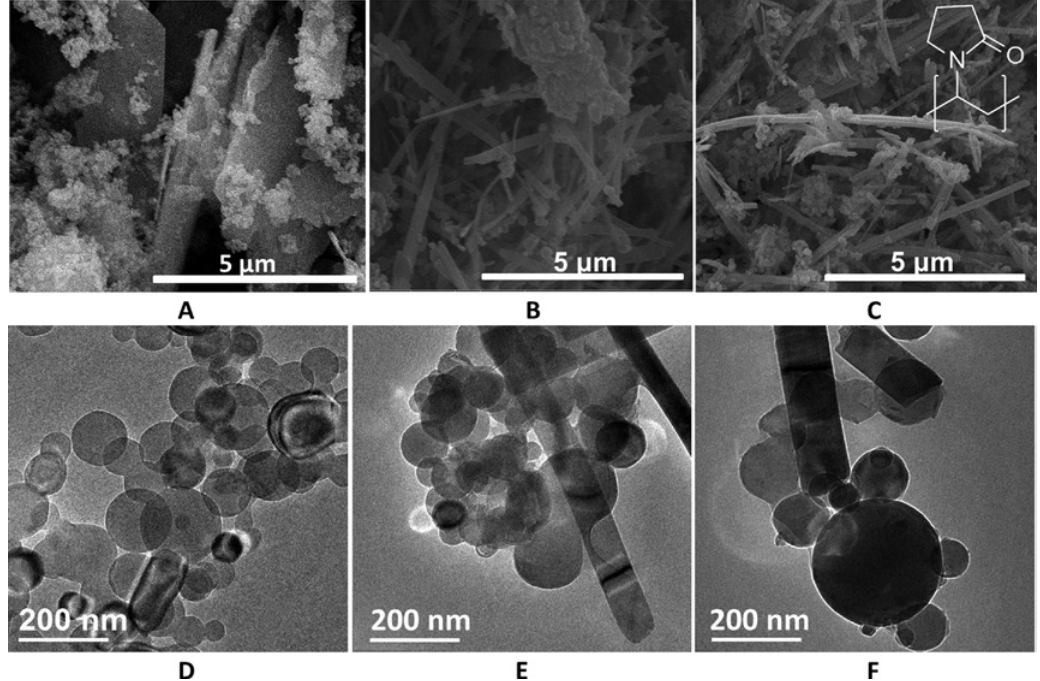
Figure 4: SEM images of the Mo-Al-0 (A), Mo-Al-1 (B), and Mo-Al-2 (C) composites and TEM images of Al-NPs (D) and Mo-Al-2 (E and F). The inset in (C) is the formula of PVP. The molar ratios of MoO